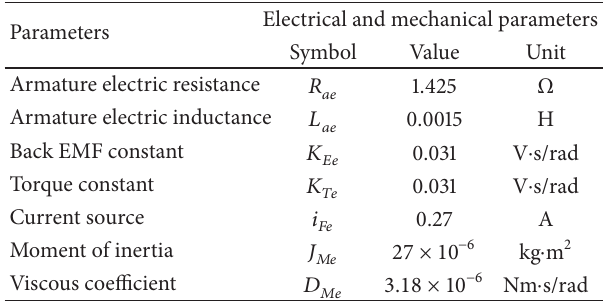
Figure 5: Mechanism of elevation motion and linear actuator. Table 2: Linear motor SM4S900M3C3 series